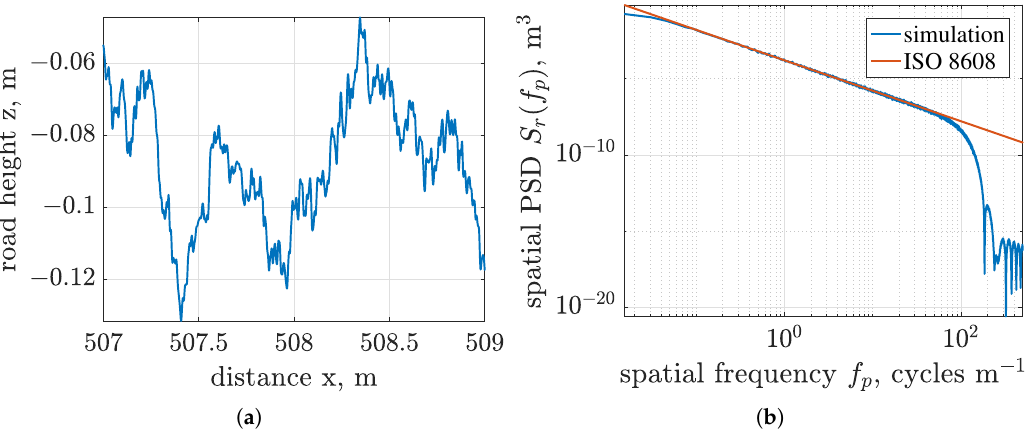
Figure 2. Standard road profile of class F: ( a ) with respect to the longitudinal coordinate, ( b ) spatial power spectral density (PSD) with respect to the spatial